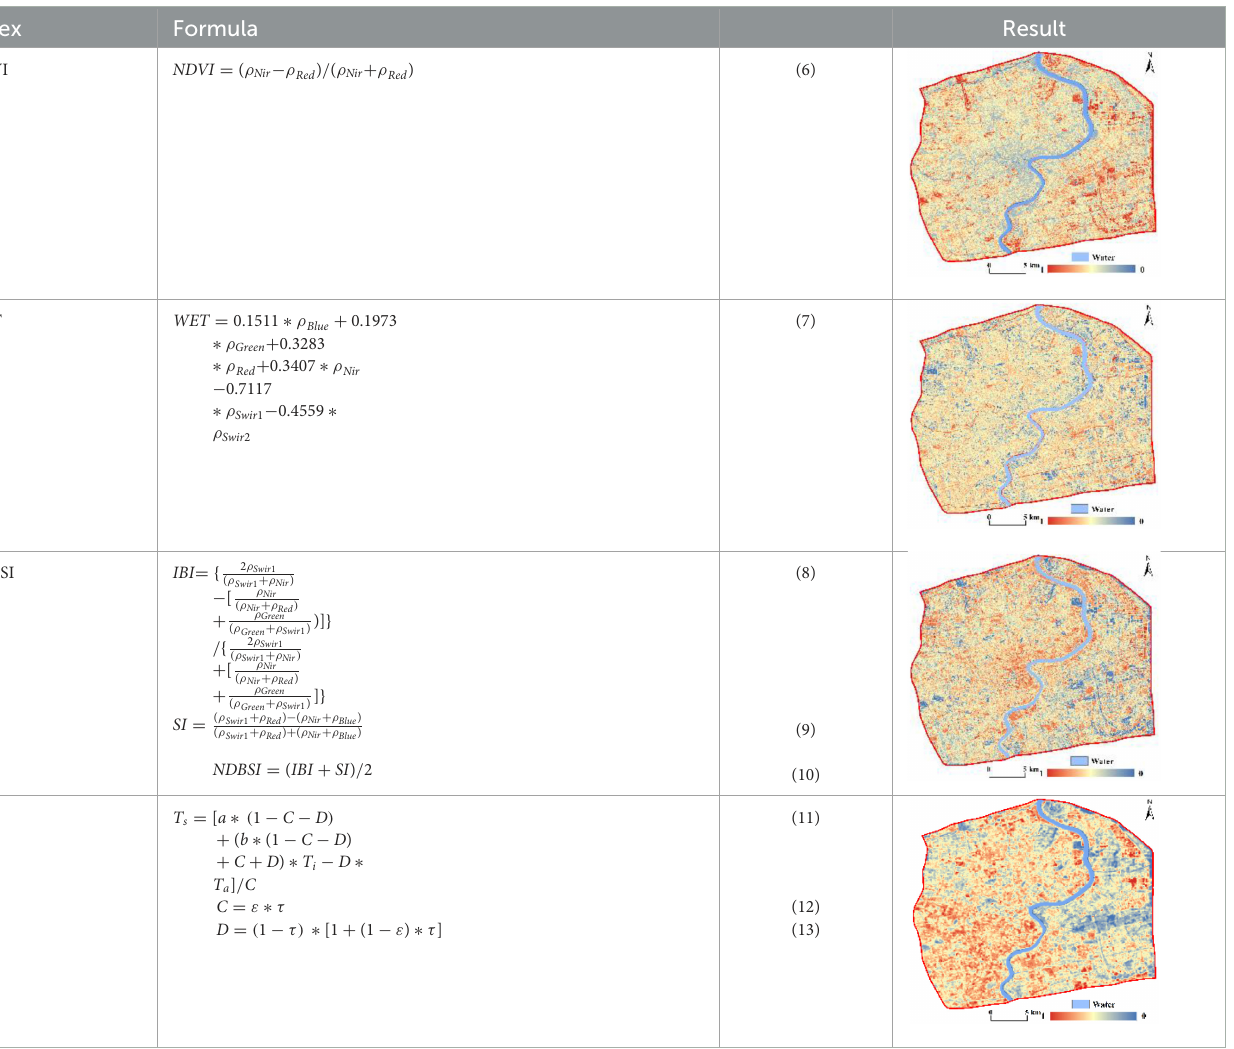
TABLE 3 Calculation of